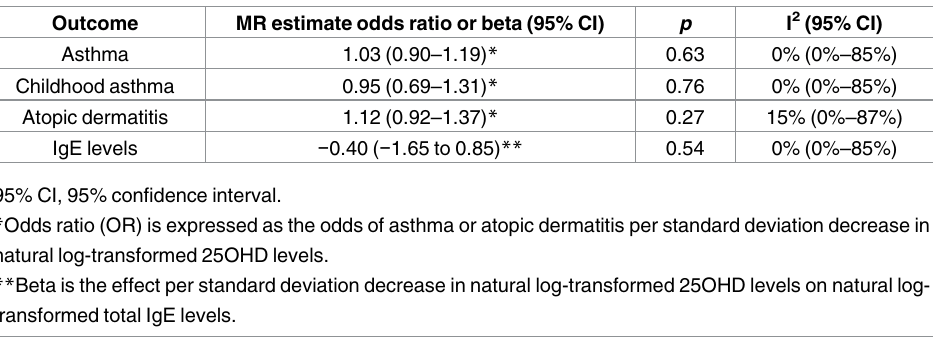
Table 2. Mendelian Randomization (MR) estimatesof the association of decreased25-hydroxyvitamin D (25OHD) on the risk of asthma, atopic dermatitis, and elevatedImmunoglobulin E (IgE)